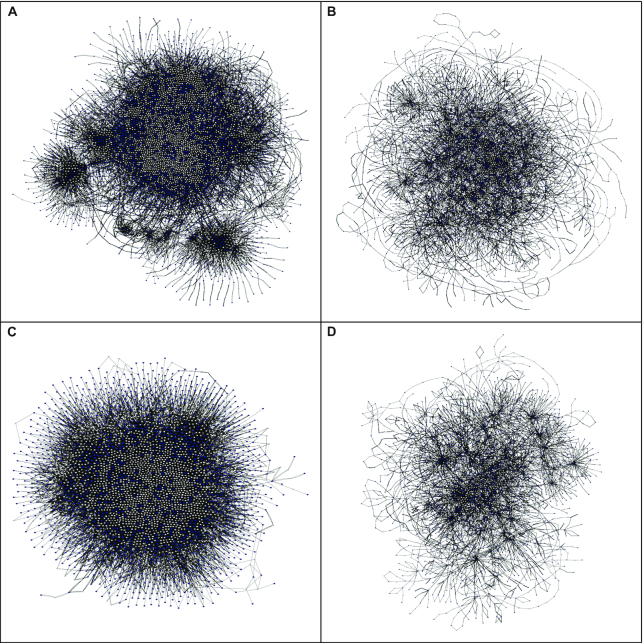
Global structures of metabolic networks. Alternative definitions of metabolic networks differ in global structure. Visual representations of metabolic networks in Cytoscape [42] with identical visual styles and layout parameters. A, Compartmental network with hubs. B, Compartmental network without hubs. C, Non-compartmental network with hubs. D, Non-compartmental network without hubs.